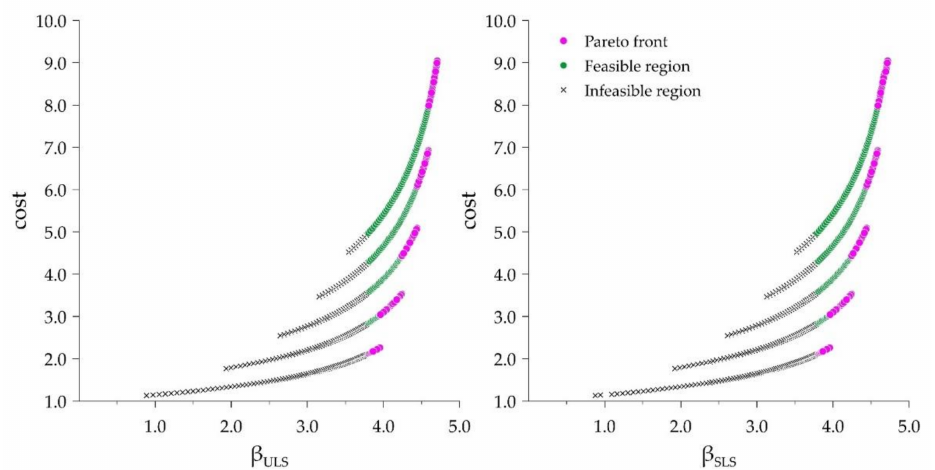
Figure 18. The projections of the Pareto front, the dominated and infeasible designs onto planes β ULS − cost and β SLS − cost